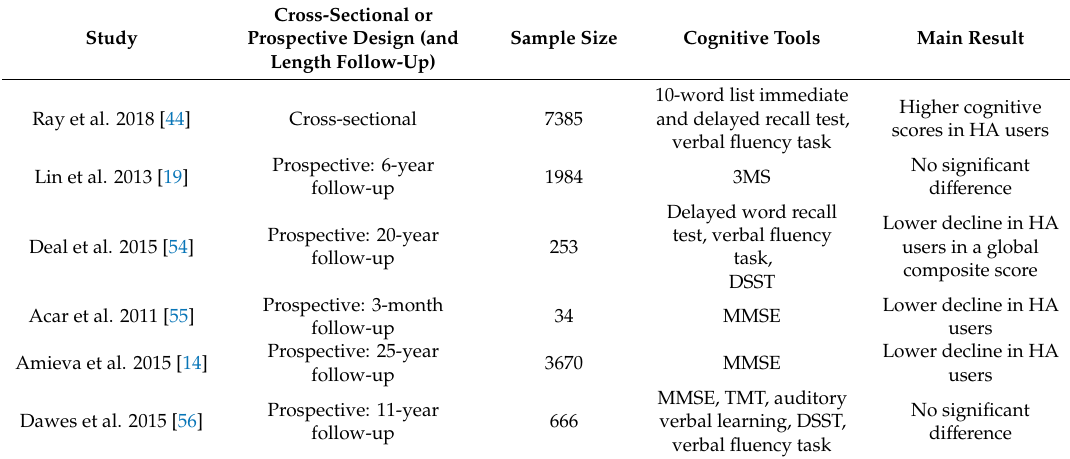
Table 1. Main studies assessing the association between hearing aid use in older adults and cognitive